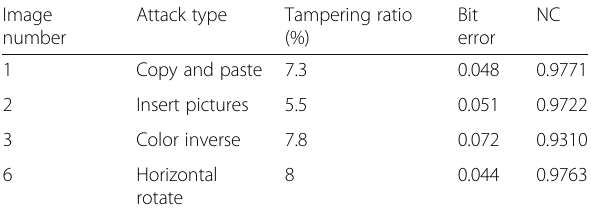
Table 4 Experiments for tampering